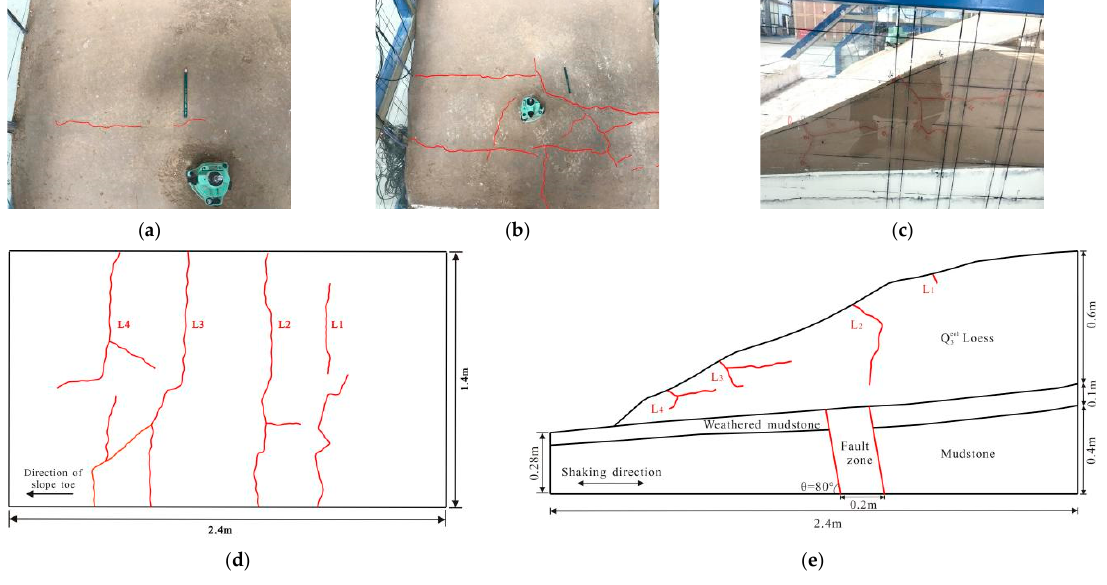
Figure 11. Dynamic deformation characteristics of slope at input PGA of ( a ) a = 0.4 g and ( b , c ) a = 0.8 g. ( d ) Top and ( e ) side view of fracture distribution.